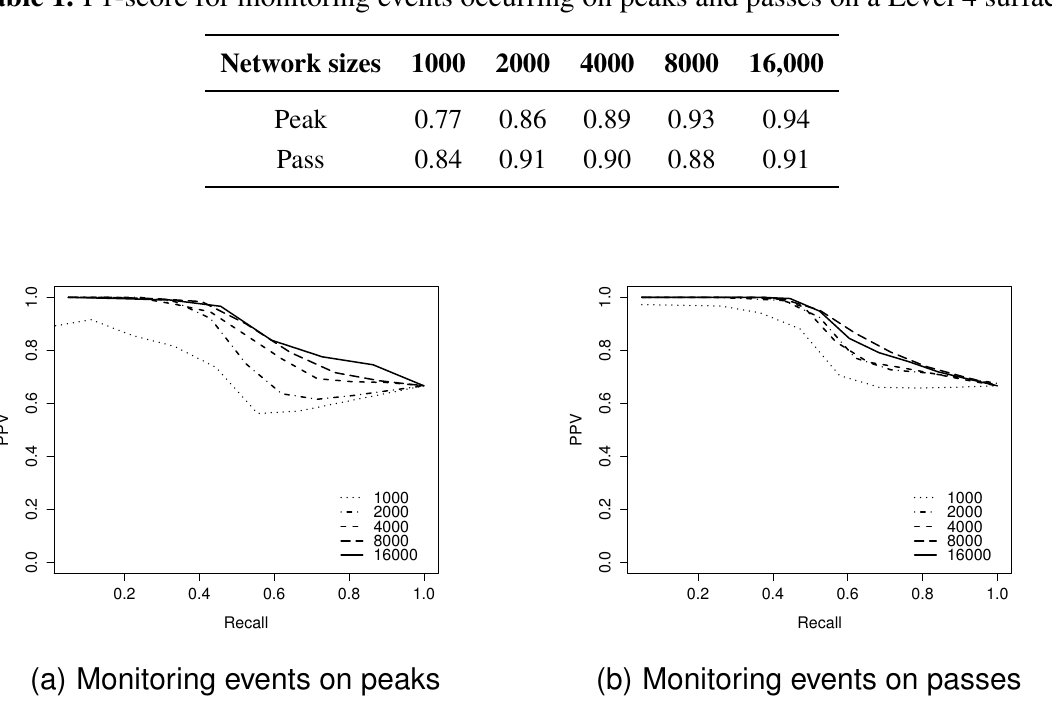
Figure 11. Positive predictive value (PPV)-recall curves for network sizes of 1000–16,000 nodes on a Level 4